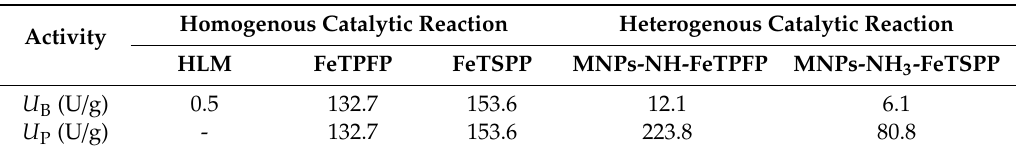
Table 3. Biocatalytic activity ( U B ) and specific biocatalytic activity ( U P ) of human liver microsomes (HLM) and metalloporphyrins (FeTPFP or FeTSPP) in their soluble (homogenous catalytic reaction) and